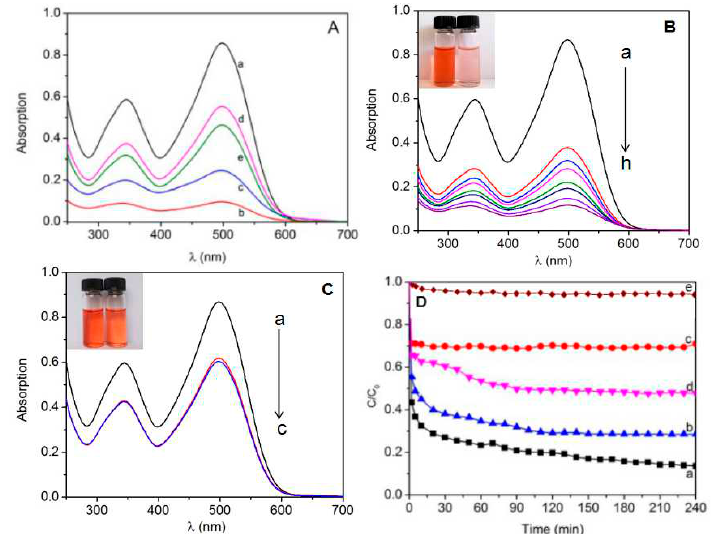
Figure 6. ( A ) The UV-Vis absorption spectra of aqueous solutions of Congo red (15 mg·L − 1 ) at (a) 0 min and in the presence of ZnFe 2 O 4 (b) CNA1, (c) CNA2, (d) CNA3, (e) CNA4 for 60 min; the variations of the absorption spectra of aqueous Congo red solutions in the presence of ( B ) hollow sphere (CNA1) at different time intervals of (a) 0, (b) 2, (c) 5, (d) 10, (e) 40, (f) 80, (g) 150 and (h) 240 min and ( C ) solid sphere (CNA3) at different time intervals of (a) 0, (b) 5 and (c) 240 min; and ( D ) the variations of adsorption rates of Congo red on (a) CNA1, (b) CNA2, (c) CNA3, (d) CNA4, and (e) in the absence of ZnFe 2 O 4 CNAs under dark conditions. c 0 (mg·L − 1 ) is the initial concentration of the Congo red solution, and c (mg·L − 1 ) is the Congo red concentration obtained after different time intervals during the adsorption.